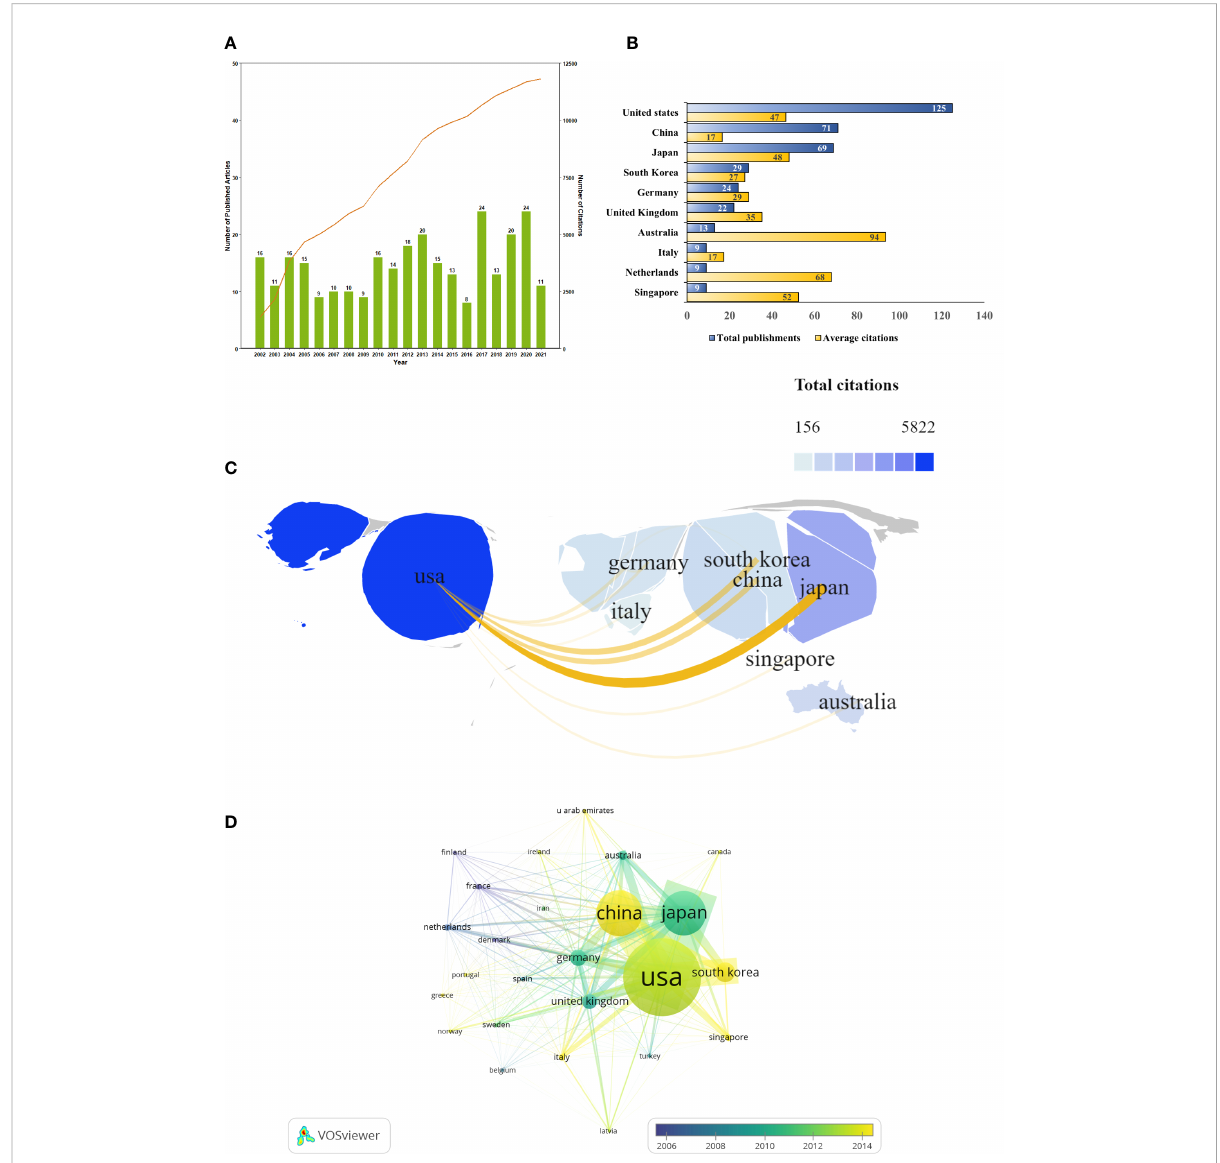
FIGURE 2 SPEM-GC publications trends and co-occurrence map over the last two decades. (A) Global trend in publication outputs and total citations per year on SPEM-GC from 2002 to 2022. (B) Core countries/regions of publications and average citations on SPEM-GC from 2002 to 2022. (C) The global geographic collaborations and distribution visualization map ranked the top ten countries/regions in terms of the total number of documents issued. The size of the map area represents the weight of the number of documents issued by the state accounting for the total number of documents issued, with a larger area suggesting more documents issued. The color of the map represents the total citation of articles published in each country, with a darker color representing a greater number of total citations. Yellow lines represent the intensity of joint documents issued between different regions, with wider lines representing a greater number of cooperative documents issued by the two. (D) Visualization of the citation overlay map for core countries/regions. In the node group, nodes represent countries and regions, and their size shows the number of publications. The connections between nodes represent the interrelation between citations. The width of the links reveals the citation